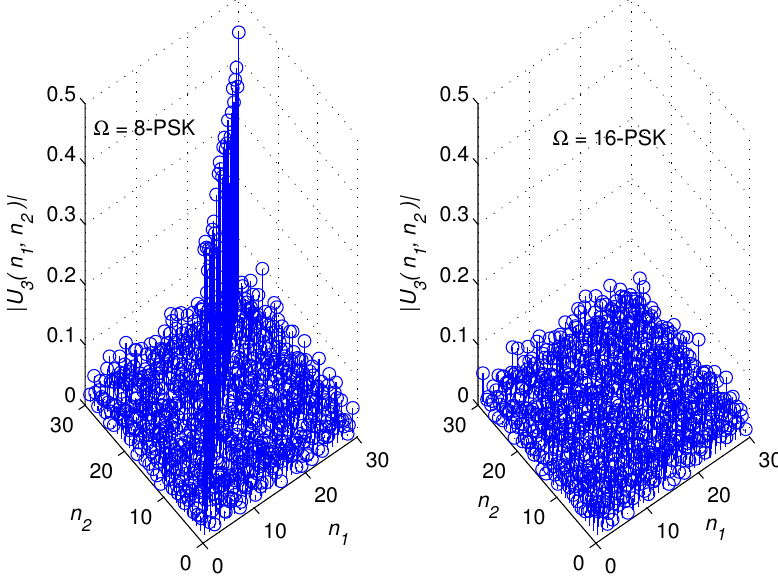
Figure 4. The magnitude of the third correlation function at the modulation forms of 8-PSK and 16-PSK.